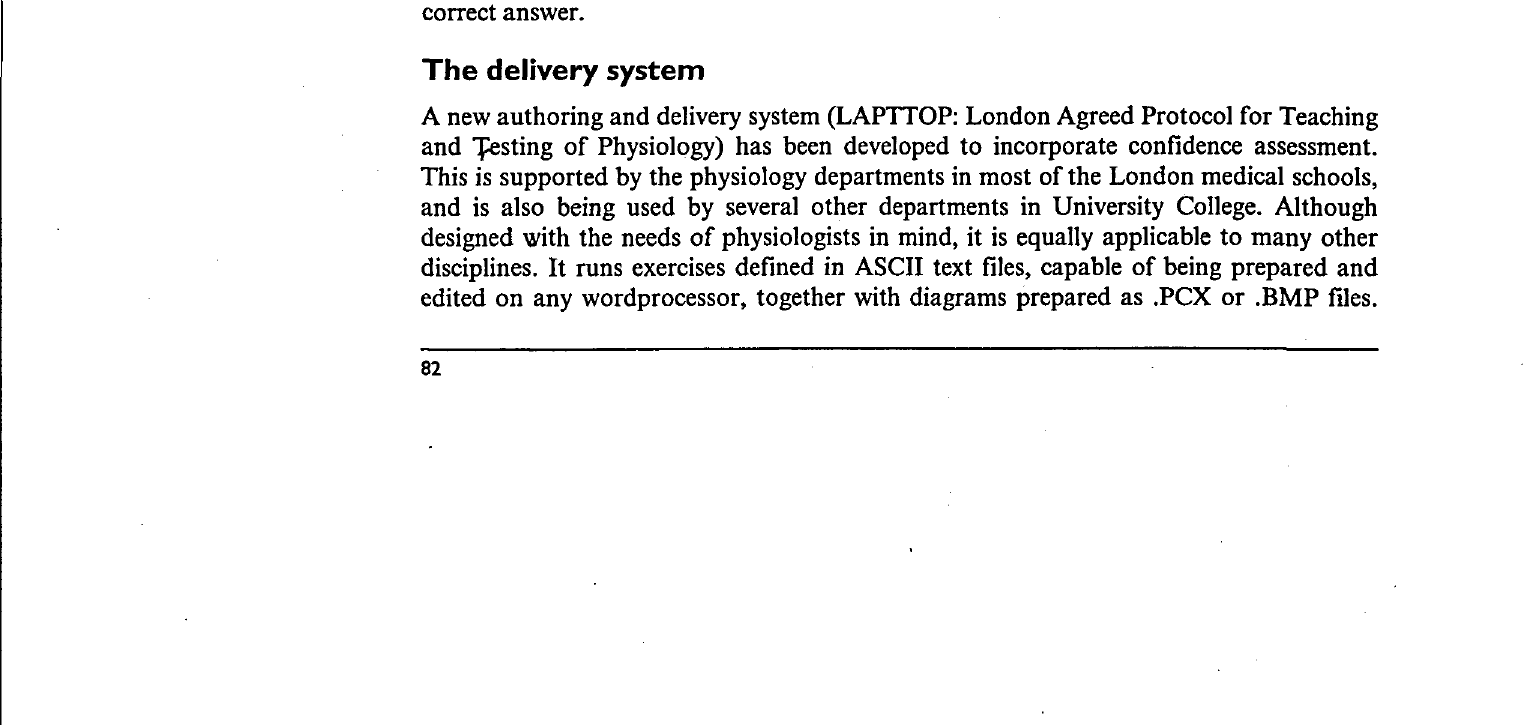
Figure I. The relation between score and the probability assigned by a student to the right answer, in a binary test The score is approximately linearly related to the logarithm of the probability, plotted on the abscissa. Note that an assigned probability of 20% means that the student has assigned 80% probability to the wrong